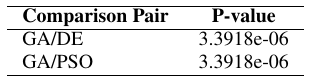
TABLE 6: Wilcoxon’s two sided rank sum